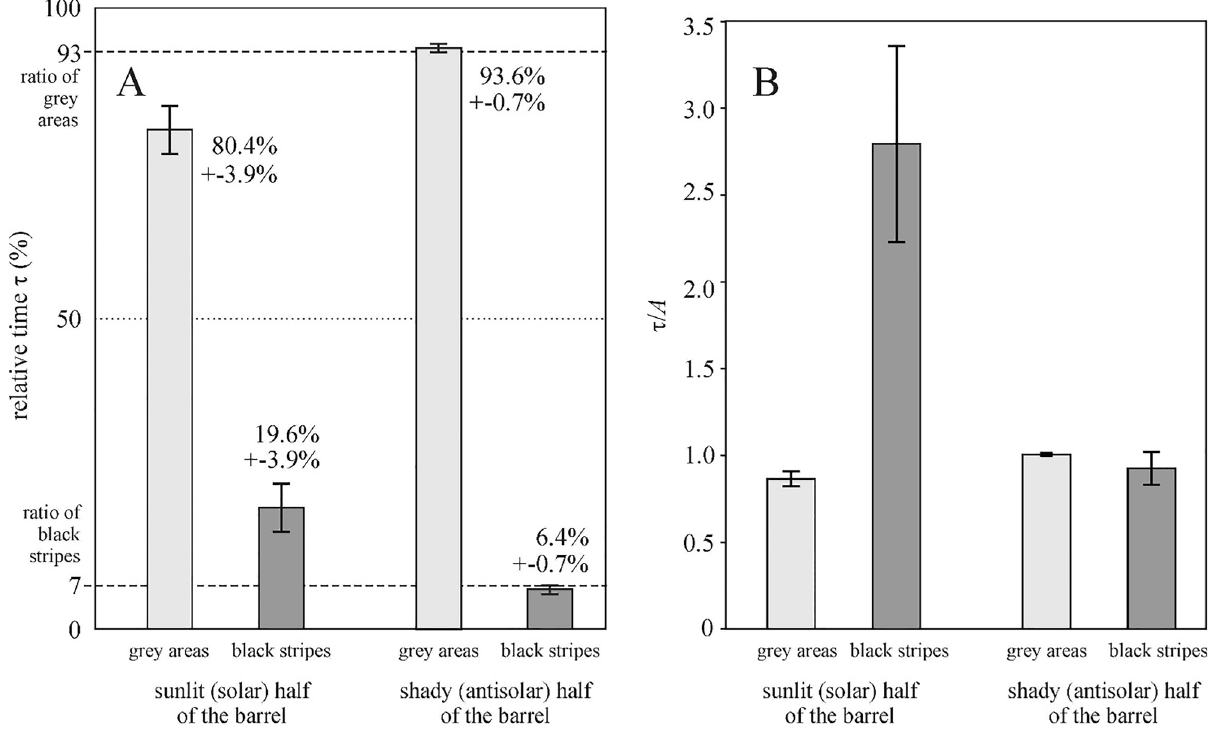
Figure 5. ( A ) Mean ± standard deviation (%) of the relative times τ grey = t grey /( t grey + t black ) and τ black = t black / ( t grey + t black ) spent by female tabanids walking on the grey areas ( t grey ) and the black stripes ( t black ) of the sunlit (solar) and shady (antisolar) halves of the barrel’s cylinder in the field experiment (Supplementary Table S1). Relative area A grey = 93% of the half cylinder was grey, and relative area A black = 7% was covered with thin black stripes. ( B ) Mean ± standard deviation of the relative-area-normalized relative times τ grey / A grey and τ black / A black (for statistics see Table